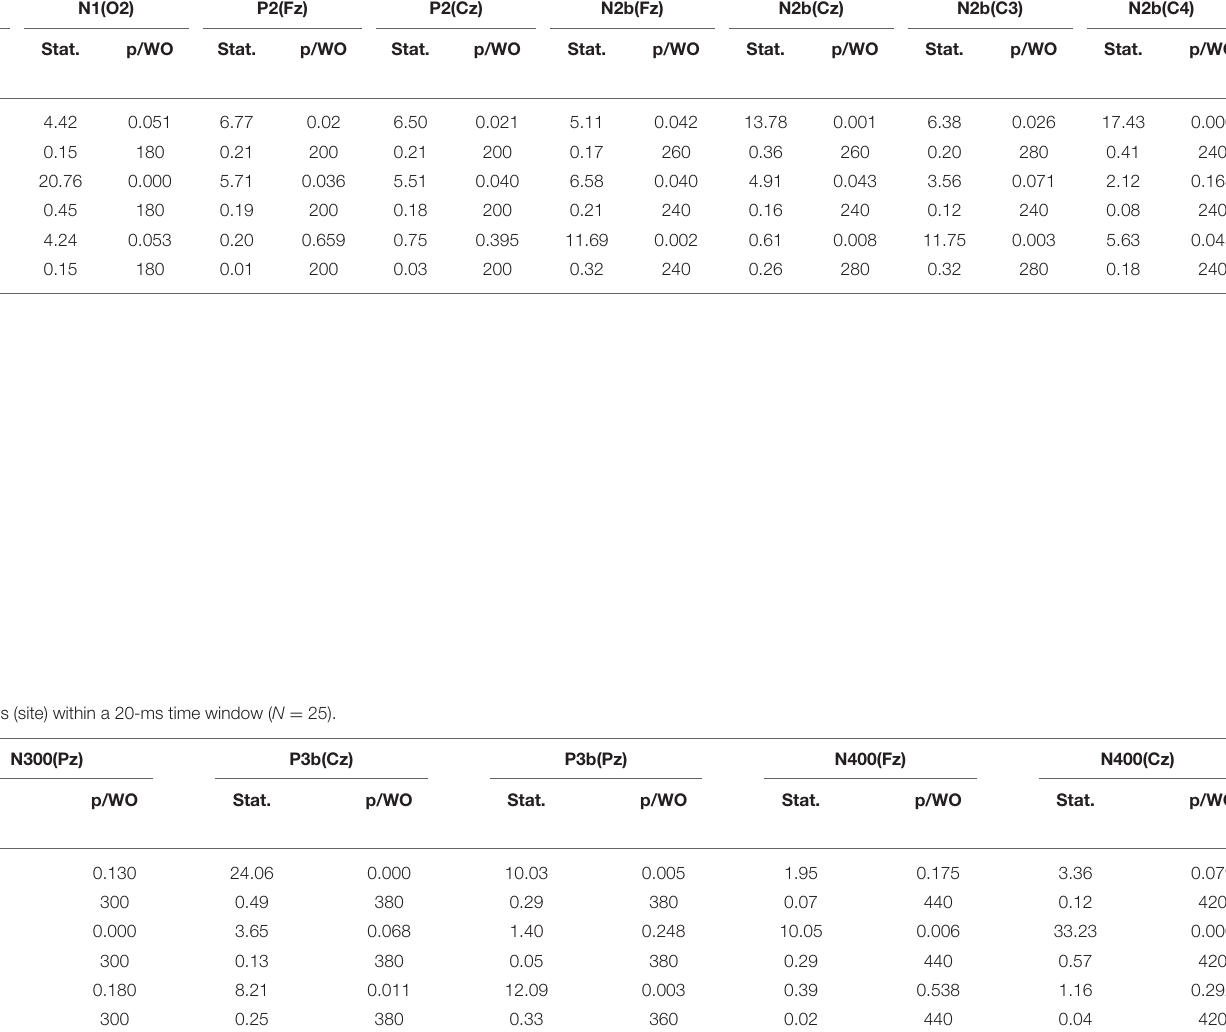
TABLE 4 | Significant N1, P2, N2b effects (site) within a 20-ms time window ( N = 25). Effect